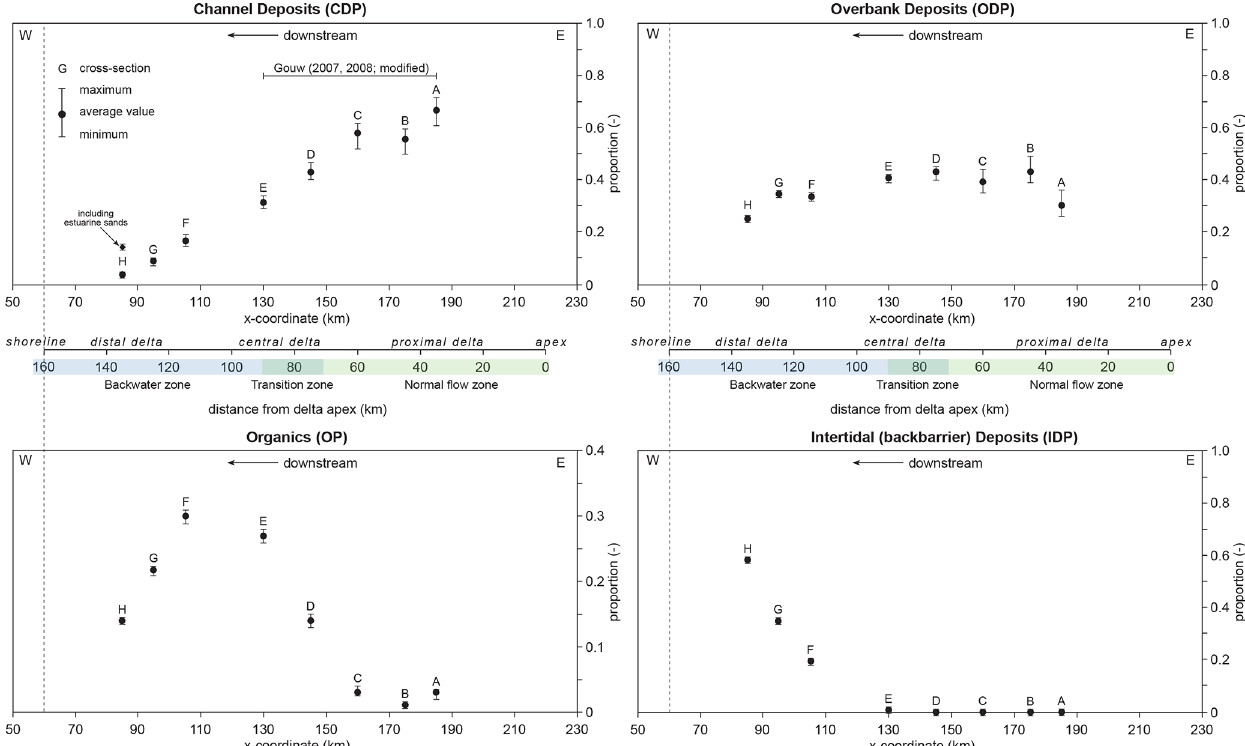
Figure 6. Proportions of channel deposits (CDP), overbank deposits (ODP), organic matter (OP) and intertidal deposits (IDP) as established for the cross sections. Ranges are as in Fig. 5. CDP clearly decreases in a downstream direction, whereas ODP is near-constant in the larger part of the Rhine–Meuse delta. OP peaks in the central-to-distal-delta transition zone and subsequently decreases coastward. This decrease is associated with a steep increase in the proportion of intertidal back-barrier deposits (IDP), which is 0.6 at a maximum in our study area. Data for sections A–E is slightly modified from Gouw (2008, 2007a). Note the different vertical scale for the OP